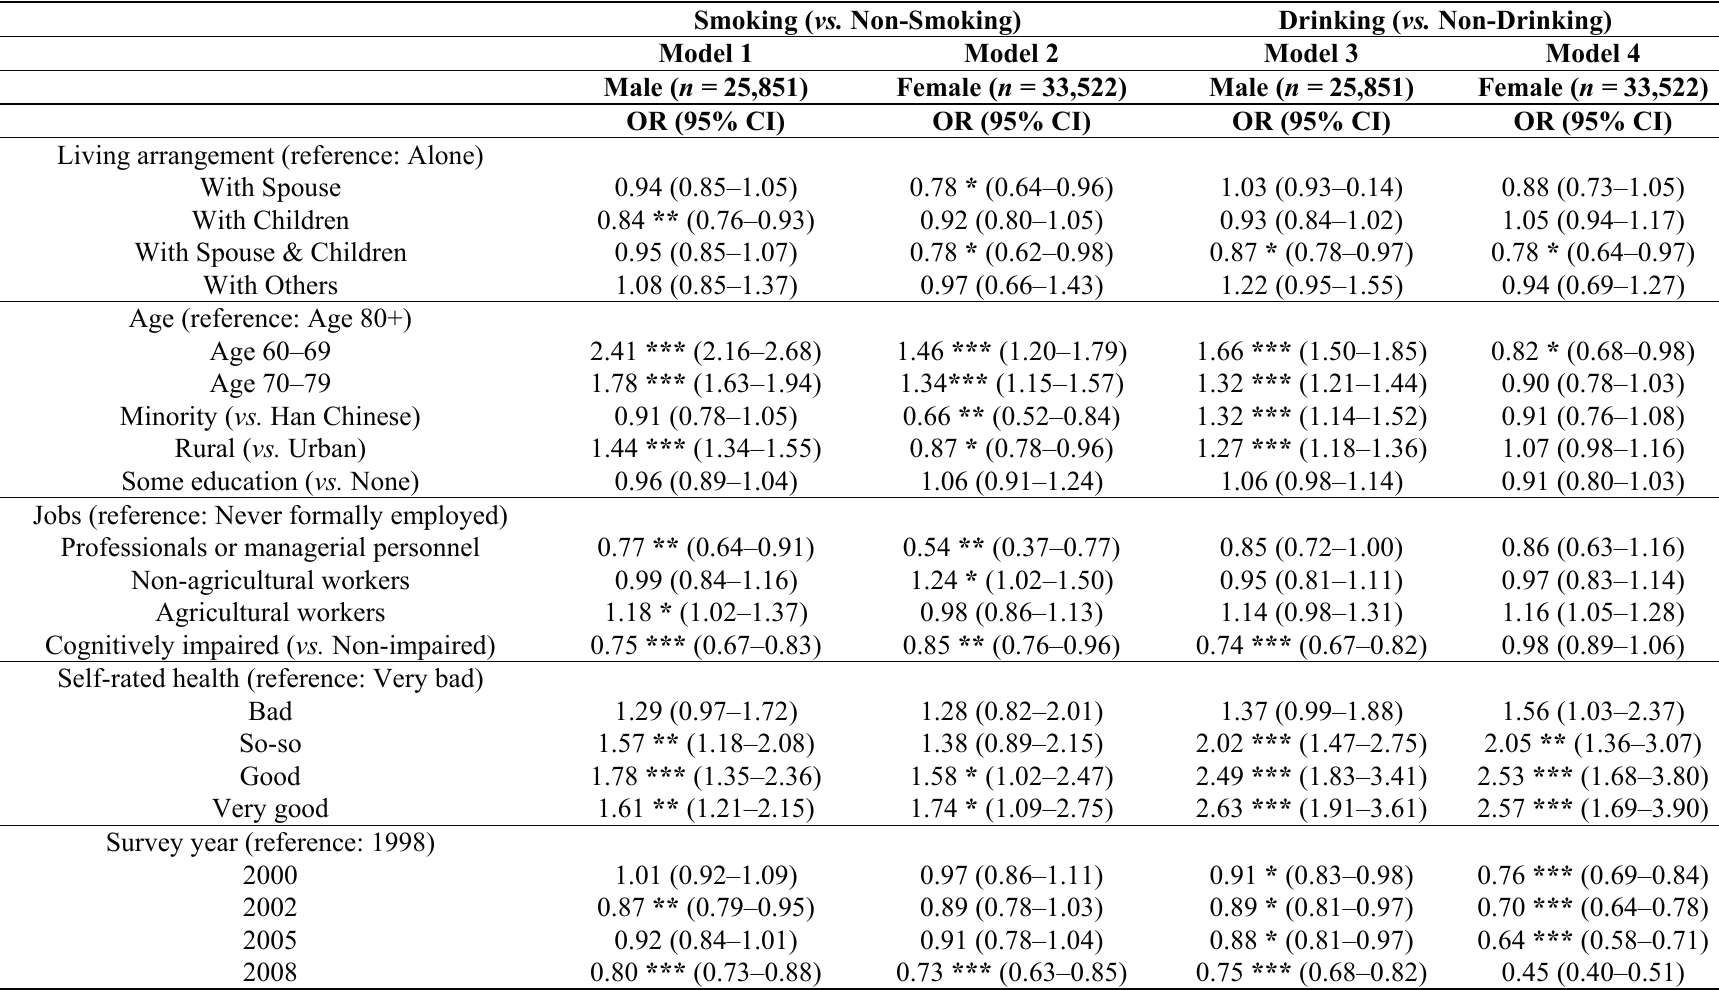
Table 2. Multivariate logistics regressions predicting smoking and drinking among Chinese older adults: CLHLS,